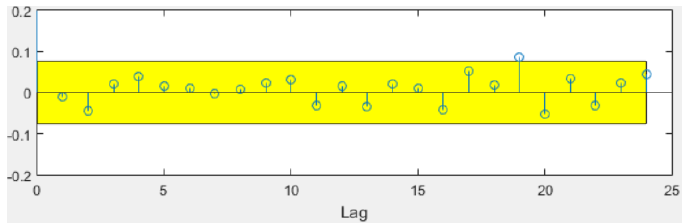
Figure 5. Error distribution for experiment B-order 3: ( a ) 15 min prediction; ( b ) 30 min prediction ( c ) 60 min prediction.